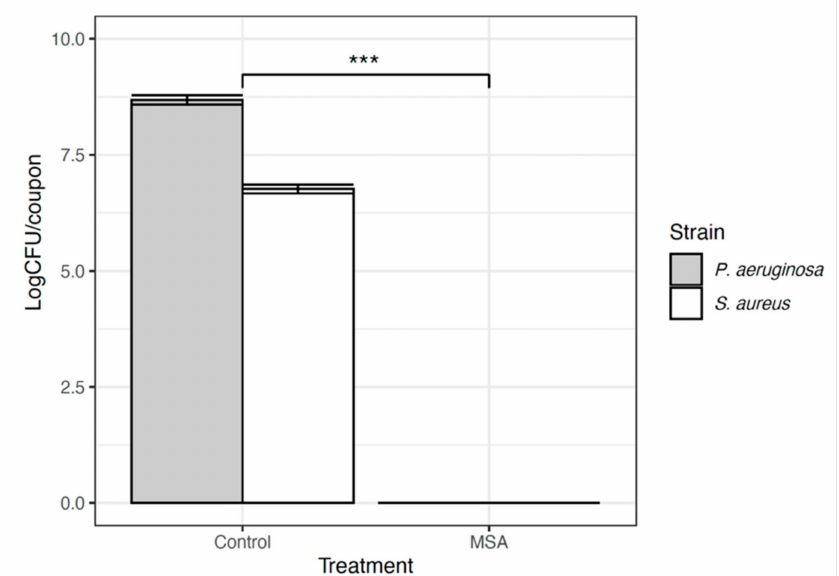
Figure 3. Results from CDC for P. aeruginosa and S. aureus reported in CFU/coupon. The error bars are demonstrating standard deviation. The *** demonstrates statistical significance of p < 0.0001.